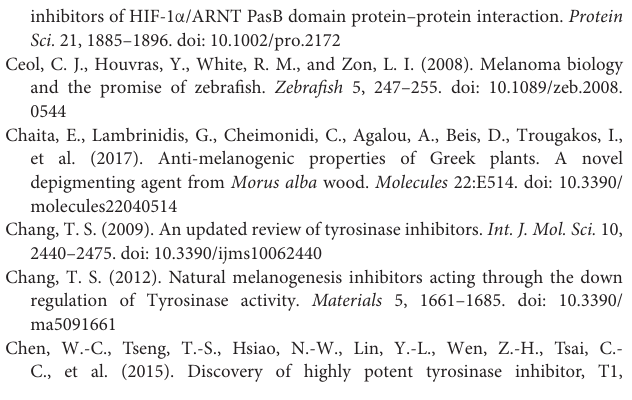
FIGURE S1 | Lethal concentrations for the compounds of the dibenzofuran family. Zebrafish embryos were incubated with compounds 1 , 2 , 3, and 4 from 3 hpf up to 96 hpf. Survival as scored and LC 50 values were calculated based on the OECD guidelines for Fish Embryo Acute Toxicity Test (TG 236). Data are mean ± standard error of the mean (SEM). FIGURE S2 | Treatment with the dibenzofuran derivatives does not affect the expression of sox10 in zebrafish embryos. Lateral views of transgenic embryos 72 hpf from line Tg(sox10:GFP) treated from 3 hpf with DMSO (A,B) or the compound 1 (C,D) . Both treated and non-treated embryos show extensive GFP expression throughout forebrain (A), anterior midbrain (B), otic epithelium (C), and branchial arches (D) while in lateral views of the trunk there is increased GFP expression in oligodendrocytes (arrow) and Schwann cells (arrowhead). FIGURE S3 | Multiple sequence alignment of the PAS-B domains. Human AHR (275–391), HIF-1 α (238–347), and HIF-2 α (234–349) employed in the homology modeling. The sequence identity of AHR PAS-B domain with the corresponding residues of HIF-1 α and HIF-2 α is 26.7% and 25.4%, respectively. FIGURE S4 | Ramachandran plot from a PROCHECK analysis of the PAS-B domain residues 275–391 of the human AHR model used in the docking calculations. TABLE S1 | Sequences of primers used in real-time